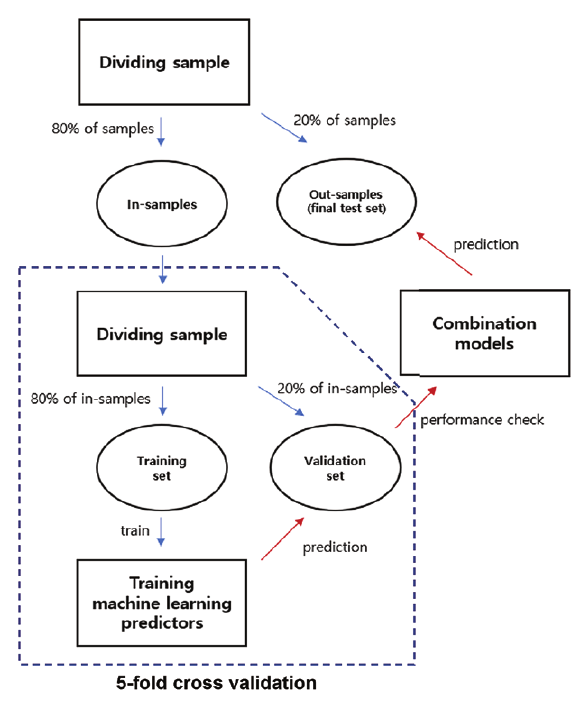
Figure 1. Flowchart illustrating our